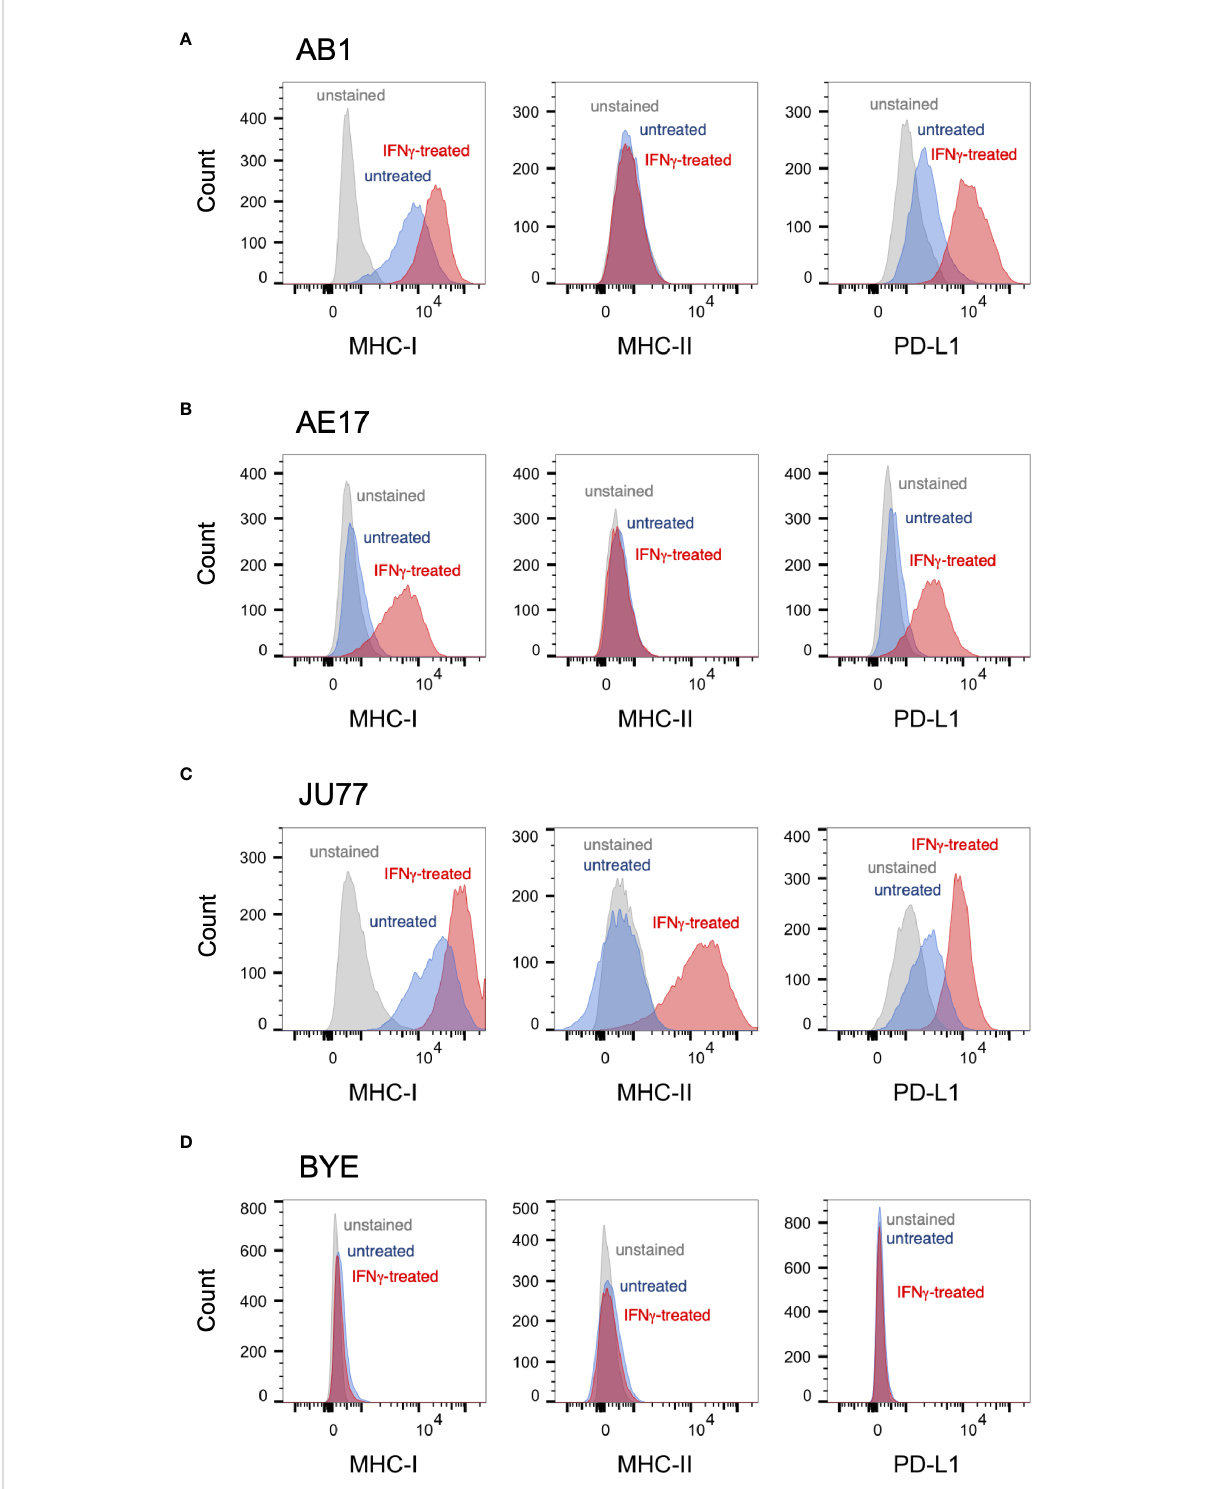
FIGURE 1 Basal expression of immune markers on mesothelioma cell lines measured by fl ow cytometry. (A – D) Representative histograms of surface MHC-I, MHC-II and PD-L1 staining on untreated mesothelioma cells (blue) against unstained controls (grey) and IFN g -stimulated controls (red) for murine cell lines AB1 (A) and AE17 (B) , and human cell lines JU77 (C) and BYE (D)